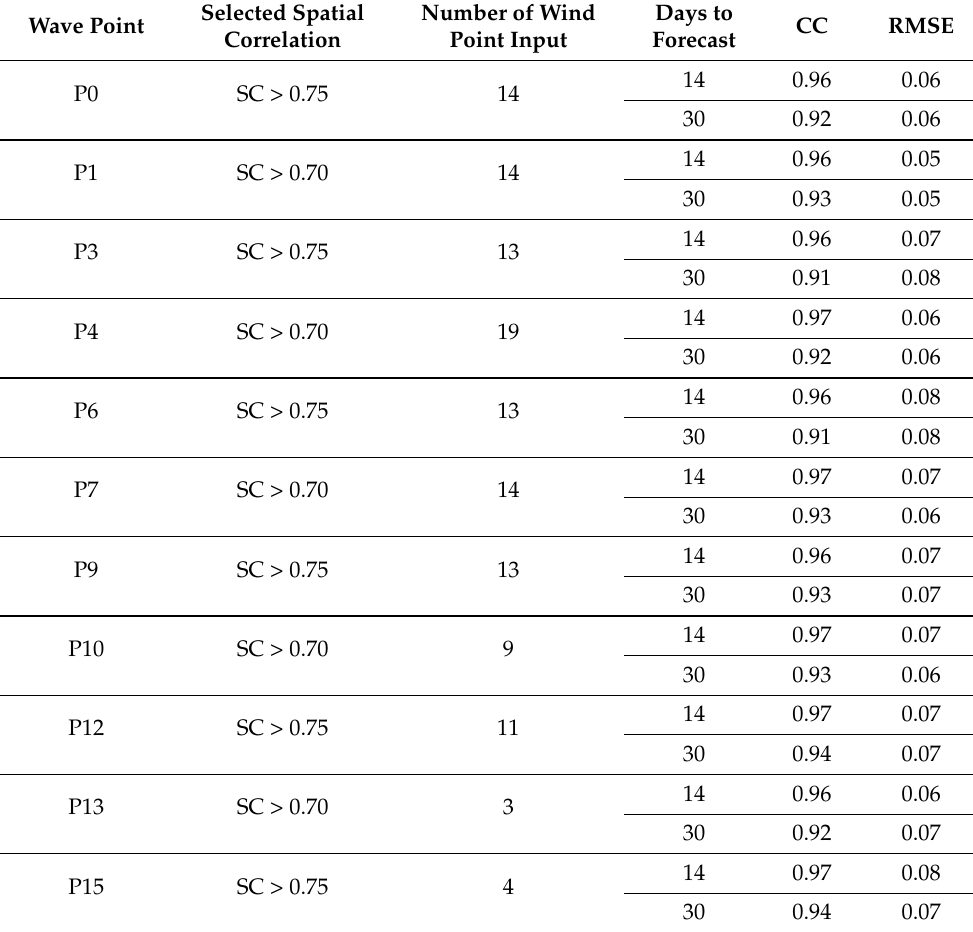
Table 5. Results of significant wave height prediction at various locations. Wave